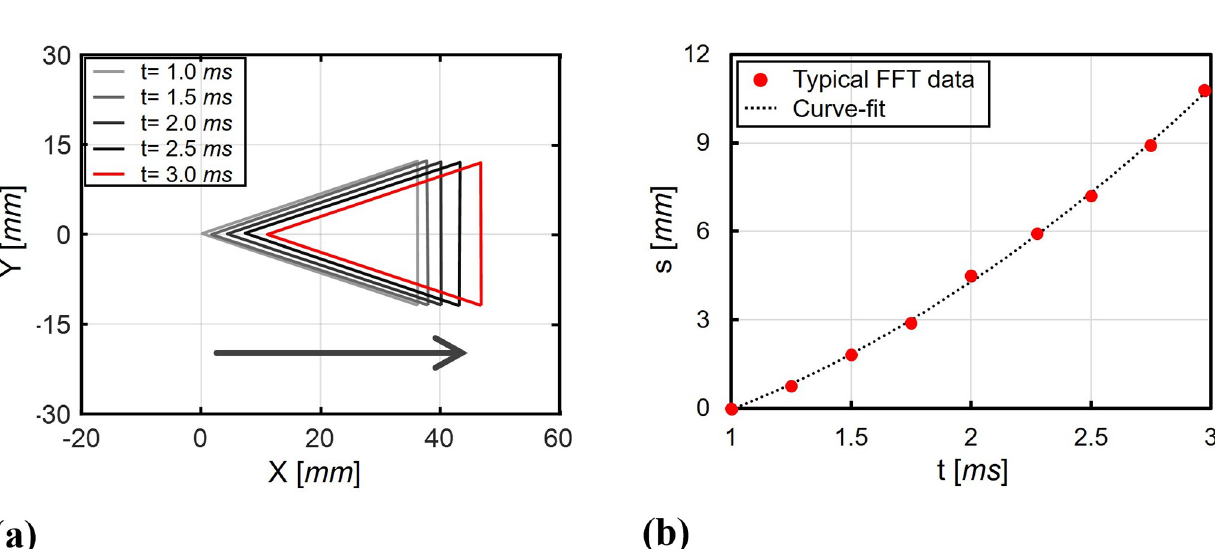
PLOS ONE | https://doi.org/10.1371/journal.pone.0270743 July 8,